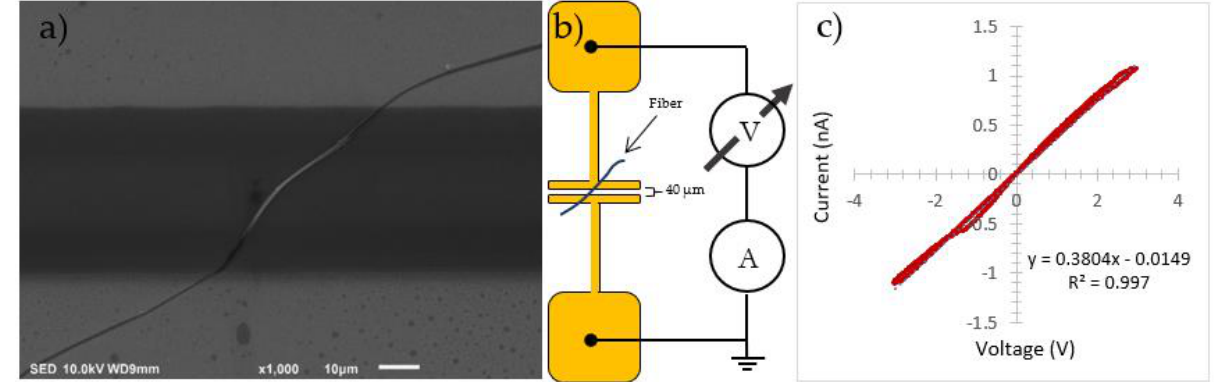
Figure 7. SEM image of coaxial nanofiber electrically connected to the BBL shell ( a ), device structure with electrode separation of 40 µm ( b ), and current-voltage (I – V) characterization of a single fiber ( c ).